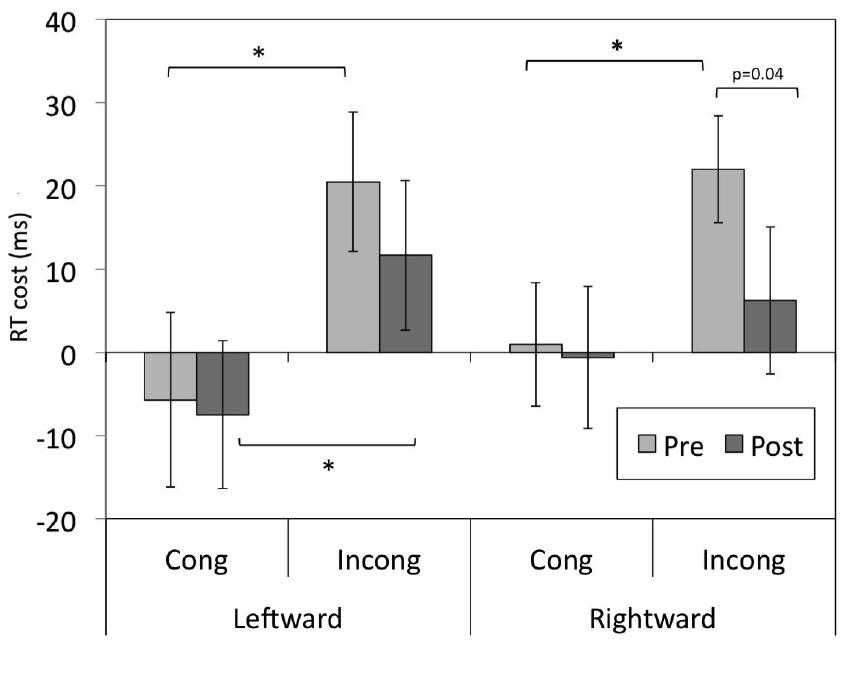
Figure 2. Data for the Prism x Congruency interaction. RT costs of alignment for congruent and incongruent trials before and after adaptation to leftward- and rightward-shifting prisms. Error bars represent ± SEM, *=significant to a Bonferroni-corrected alpha level of p =0.0125